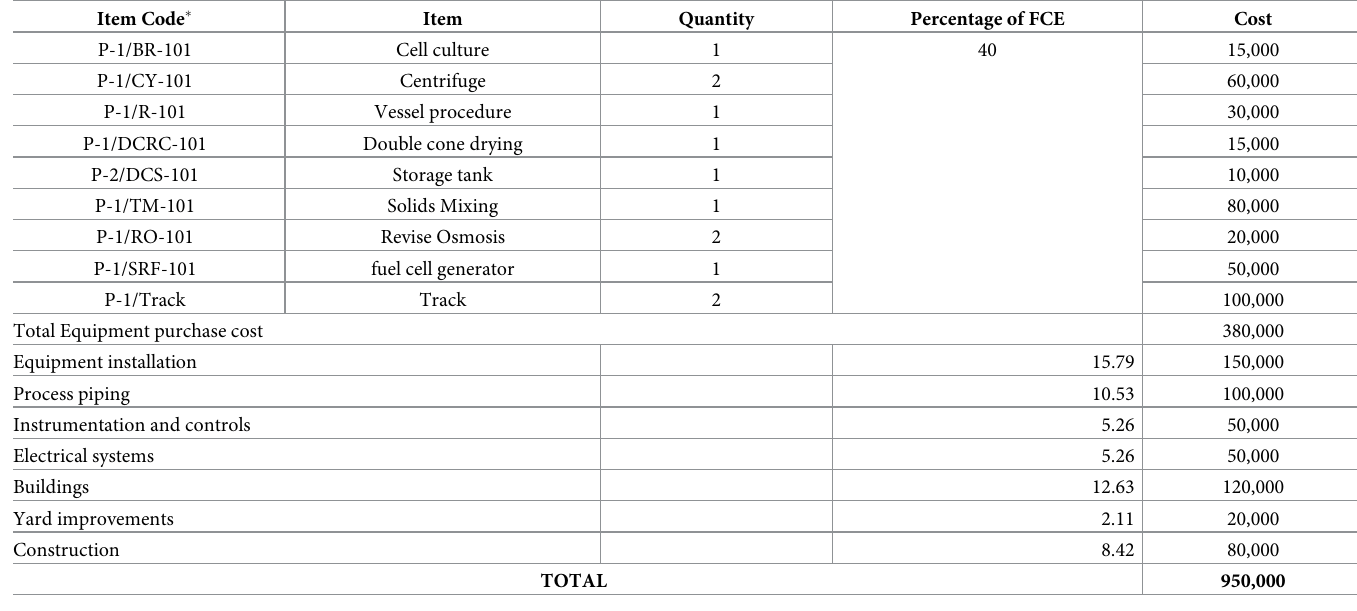
Table 3. Fixed capital estimate (FCE) for biosynthesis of Cu/Zn NPs and application in inactivating pathogenic bacteria in